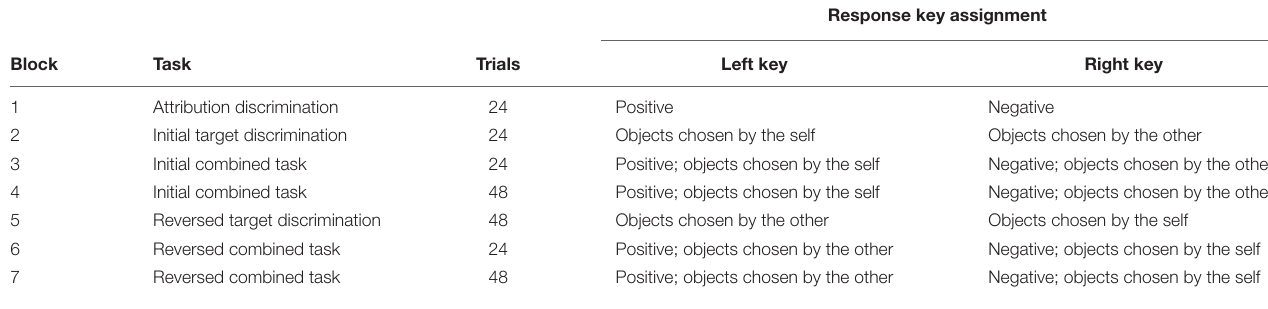
TABLE 1 | Task process of the IAT paradigm in Studies 1 and 2.